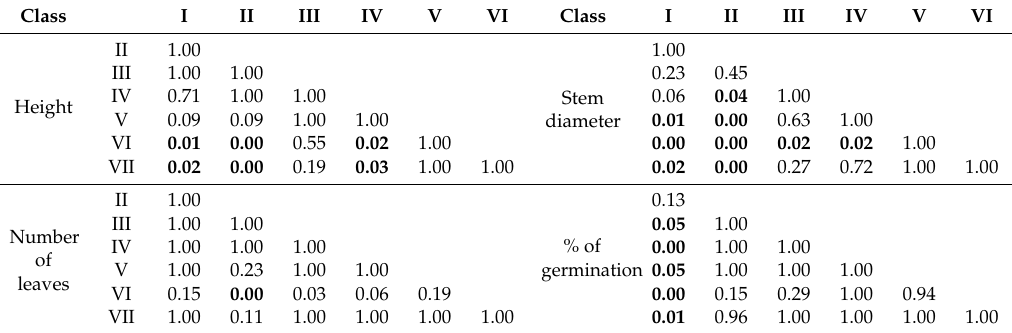
Figure 2. Regression analysis of seed mass of the pecan cv. Importada with means of ( A ) plantlet height; ( B ) stem diameter; ( C ) number of leaves and ( D ) emergence percentage. Linear regression equations and coefficients of determination ( R 2 ) are presented for the relationships. Table 1. P -values for the pairwise difference between classes for the evaluated traits, based on the Mann–Whitney test with Bonferroni correction. Bold numbers are statistically significant.